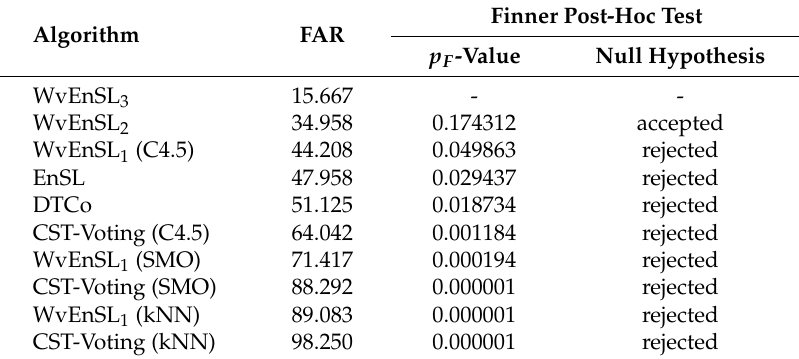
Table 5. Friedman Aligned Ranking (FAR) test and Finner post-hoc test.